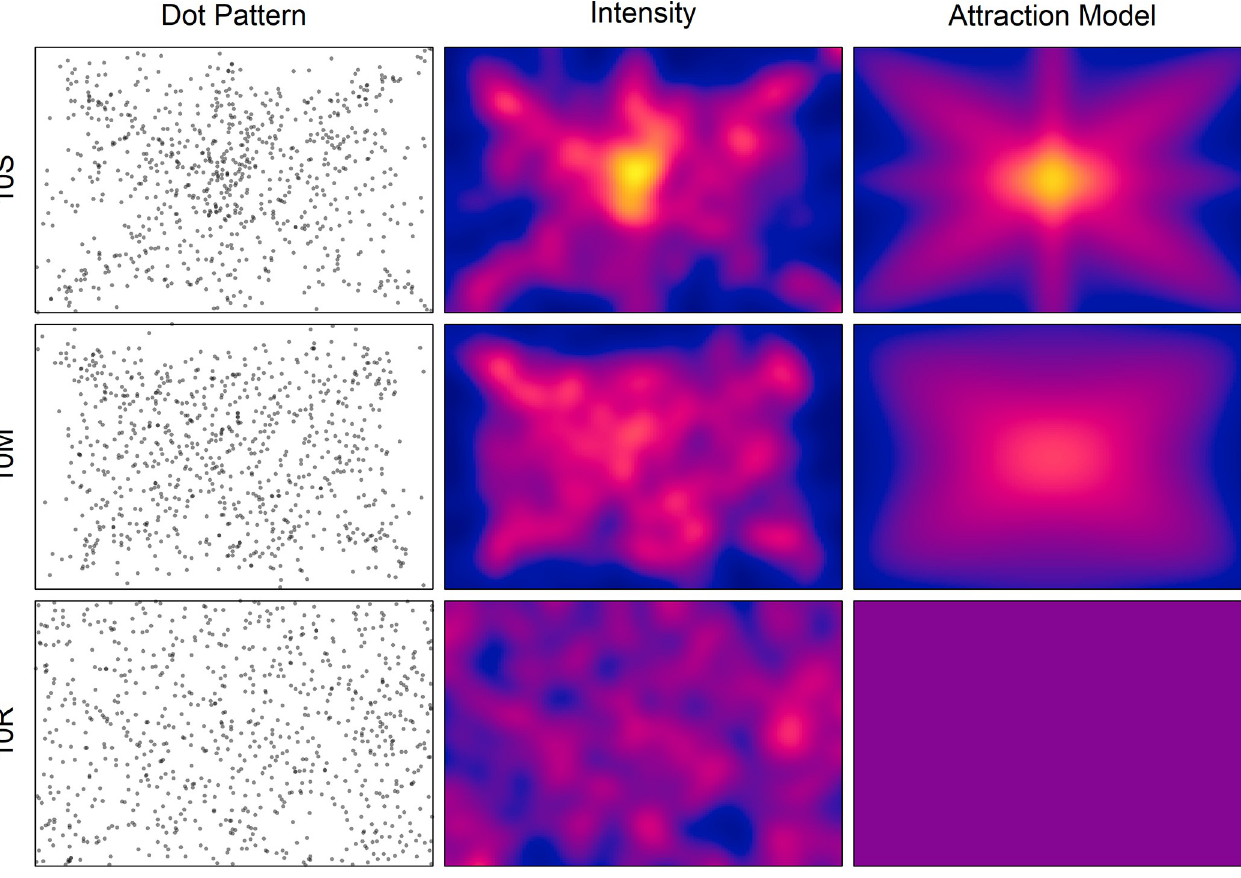
Fig 9. Superimposed dot patterns (column Dot Pattern) for the two conditions in Experiment 3, and for a corresponding random-dot pattern (10R). The maps of the corresponding estimated intensities (column Intensity) are also shown. The intensity in the maps ranges from 0.00 (blue) to 0.013 (yellow). In the right column the corresponding maps of the modelled regional attractions are depicted (see text for